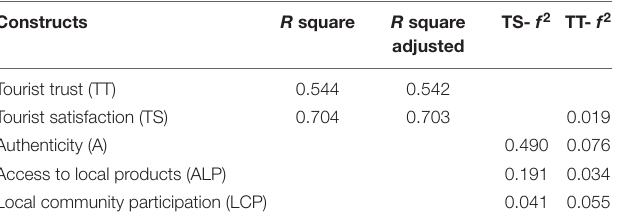
TABLE 5 | R square and F square.